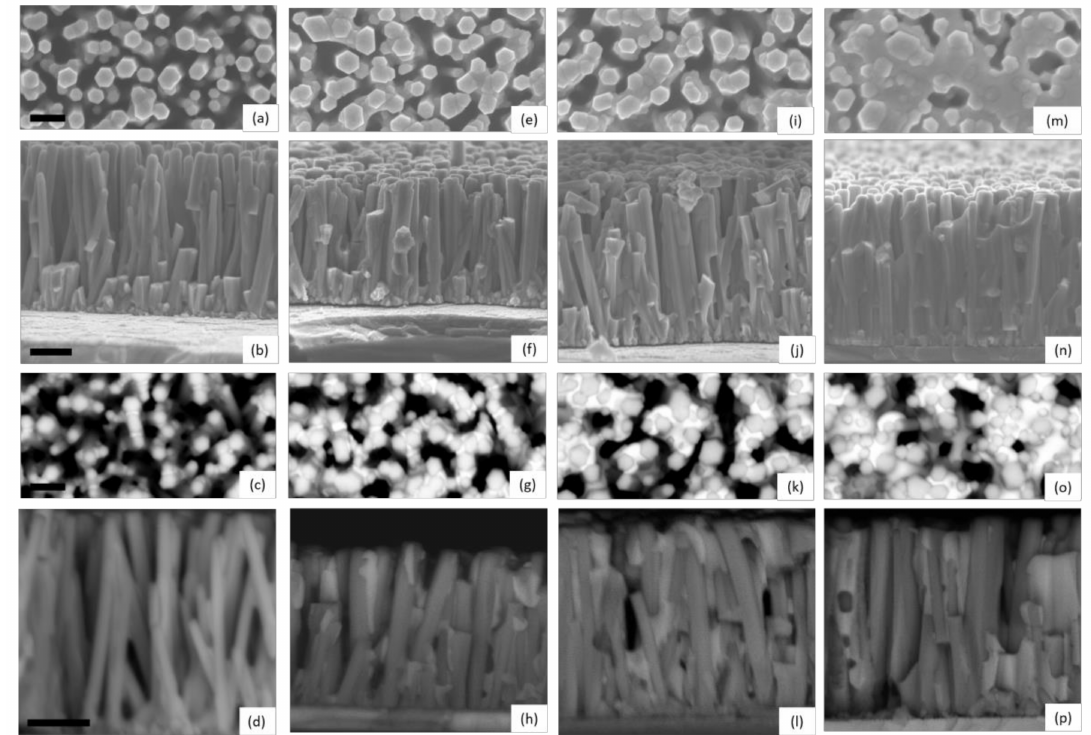
Figure 1. Top-view and cross-sectional view FESEM images of ZnO/TiO 2 core–shell NW heterostruc- tures covered with a Sb 2 S 3 shell grown by CSP, using ( a – d ) 30, ( e – h ) 50, ( i – l ) 70, and ( m – p ) 90 cycles. FESEM images were collected by using the detectors of secondary electrons ( a , b , e , f , i , j , m , n ) and backscattered electrons ( c , d , g , h , k , l , o , p ), respectively. The scale bars denote 200 and 300 nm for the top-view and cross-sectional view FESEM images,